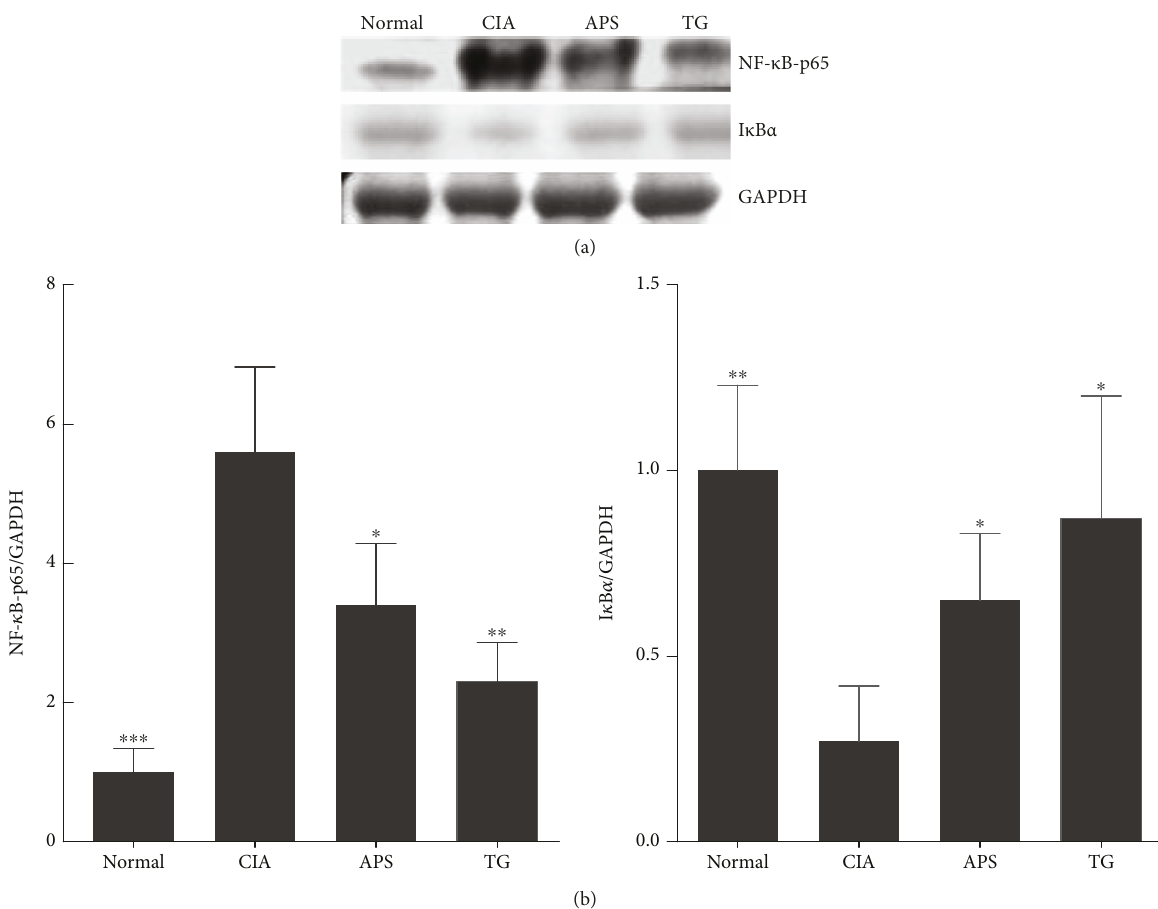
Figure 5: Western blotting analysis of the e ff ects of APS administration on protein expression of NF- κ B-p65 and I κ B α , as well as GAPDH in synovial membrane homogenates from rats in each group. (a) Representative western blots are shown. (b) Ratios of optical density are calculated on NF- κ B-p65 to GAPDH and I κ B α to GAPDH. Data represent the mean ± SD of 6 rats per group. Signi fi cant e ff ect compared to the CIA group: ∗ P < 0 05 , ∗∗ P < 0 01 , ∗∗∗ P < 0 001